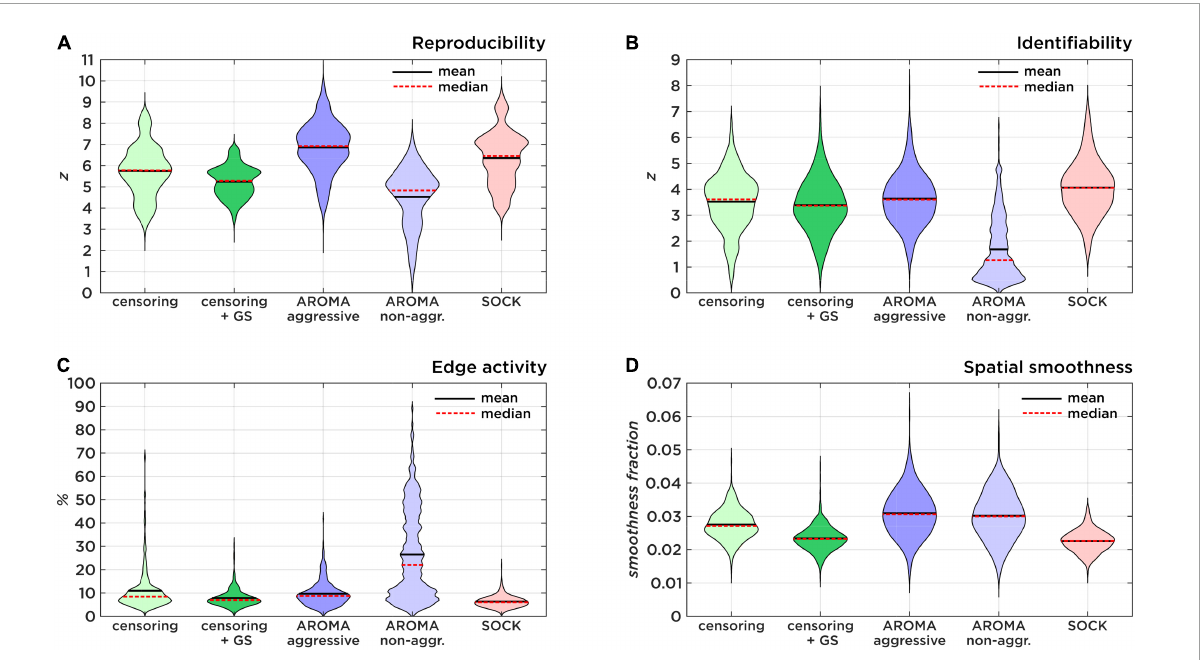
FIGURE2 Comparison of data quality metrics. (A) Shows the Reproducibility as a result of 500 random split-half permutations. (B) Shows the Identifiability as a ratio of true-positive and false-positive connectivity compared to the target region maps. (C) Shows the amount of brain edge activity after Gaussian mixture modeling as an estimator of residual subject motion. (D) Shows smoothness fractions as a measure for spatial high-frequency noise.